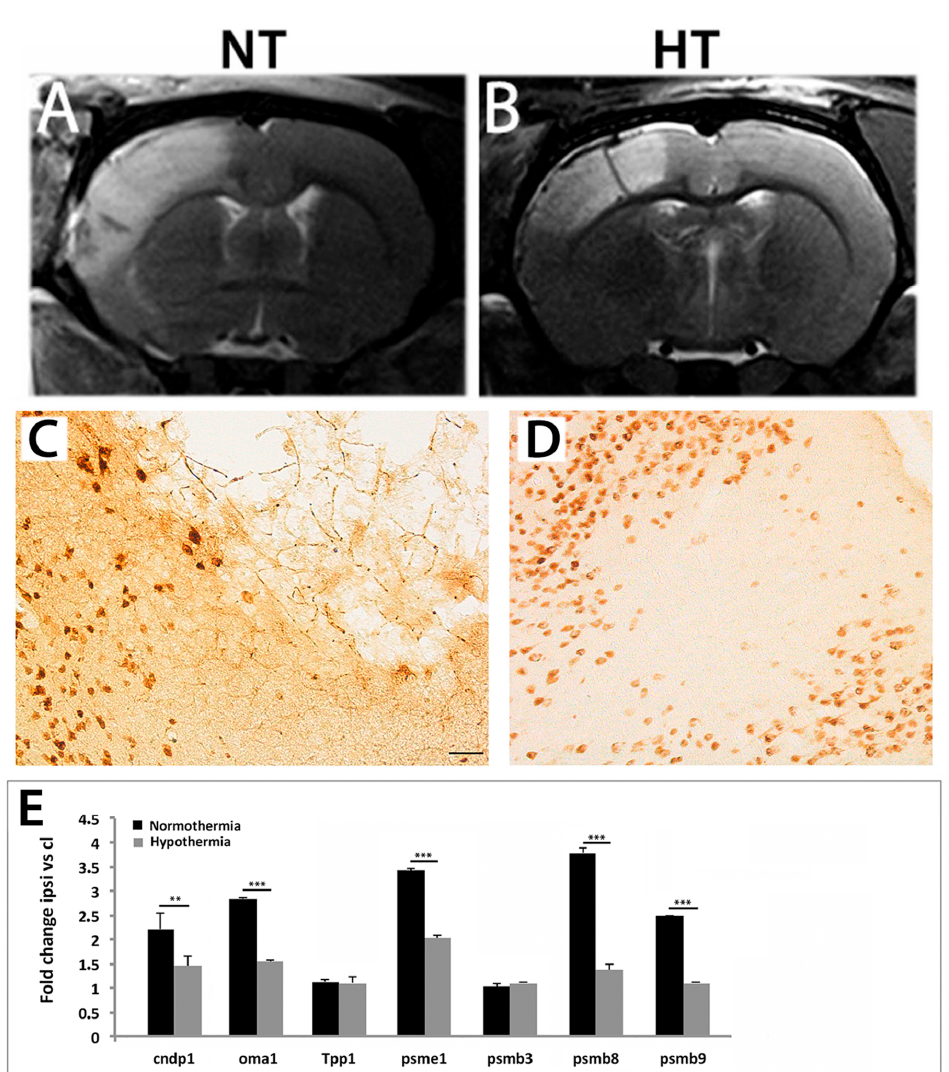
Figure 1. Forty eight hours of exposure to mild hypothermia resulted in a consistent reduction in infarct size. At 2 days post-stroke, the cortical lesion, as defined by the region of T2 hyperintensity, was reduced by the hypothermic treatment ( B ) as compared with the normothermic group ( A ) by ~42%. Tissue preservation in cooled animals (( D ) vs. ( C ), controls) was associated with large decreases (fold-changes >2) in the transcripts coding for proteasome activator complex subunit 1 (psme), proteasome subunit beta type-8 and type 9 (psmb8, psmb9) as well as significant decreases in the mRNA coding for OMA1, a mitochondrial metalloendopeptidase, and to a lesser extent cndp1, a member of the M20 metalloprotease family, early after stroke ( E ). Abbreviation s: NT, normothermia; HT, hypothermia. ** p < 0.01; *** p < 0.001, scale bar: 100 μ m.